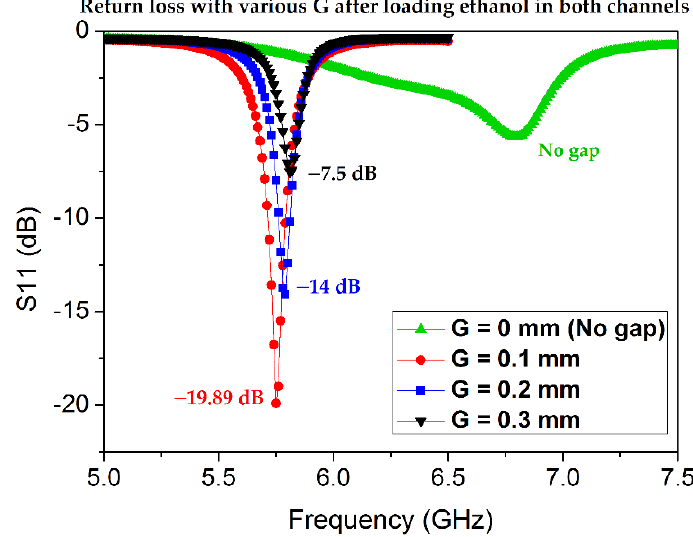
Figure 6. Parametric analysis for investigating the critical coupling gap for the final design. G = 0.1 mm is found to be the best impedance-matched case under the criterion that the microfluidic channels are loaded with ethanol.